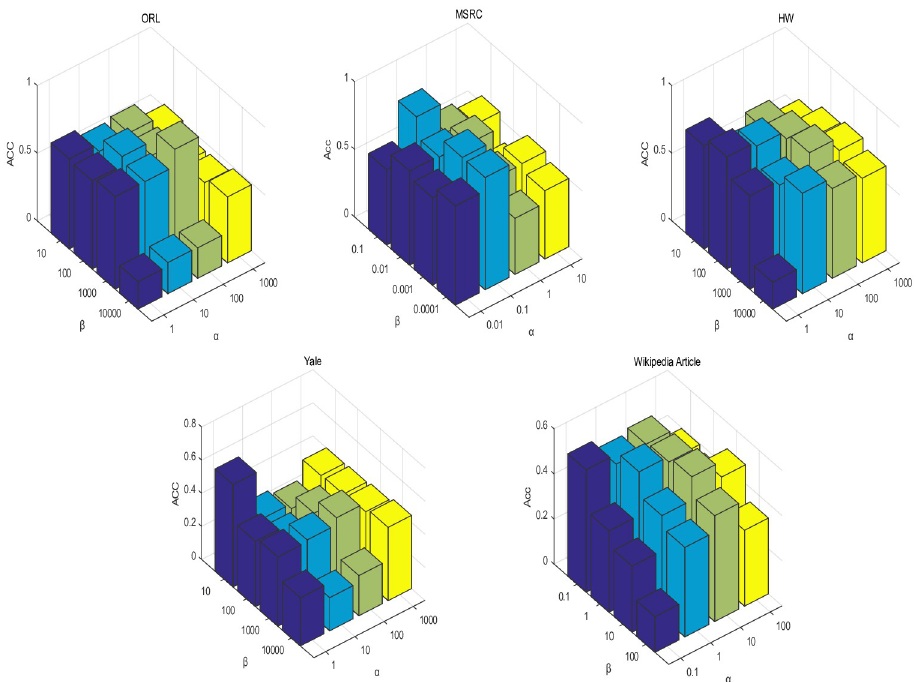
Fig 12. The influence of the changes of hyperparameters α , β , and γ on the results of Acc on the five datasets.